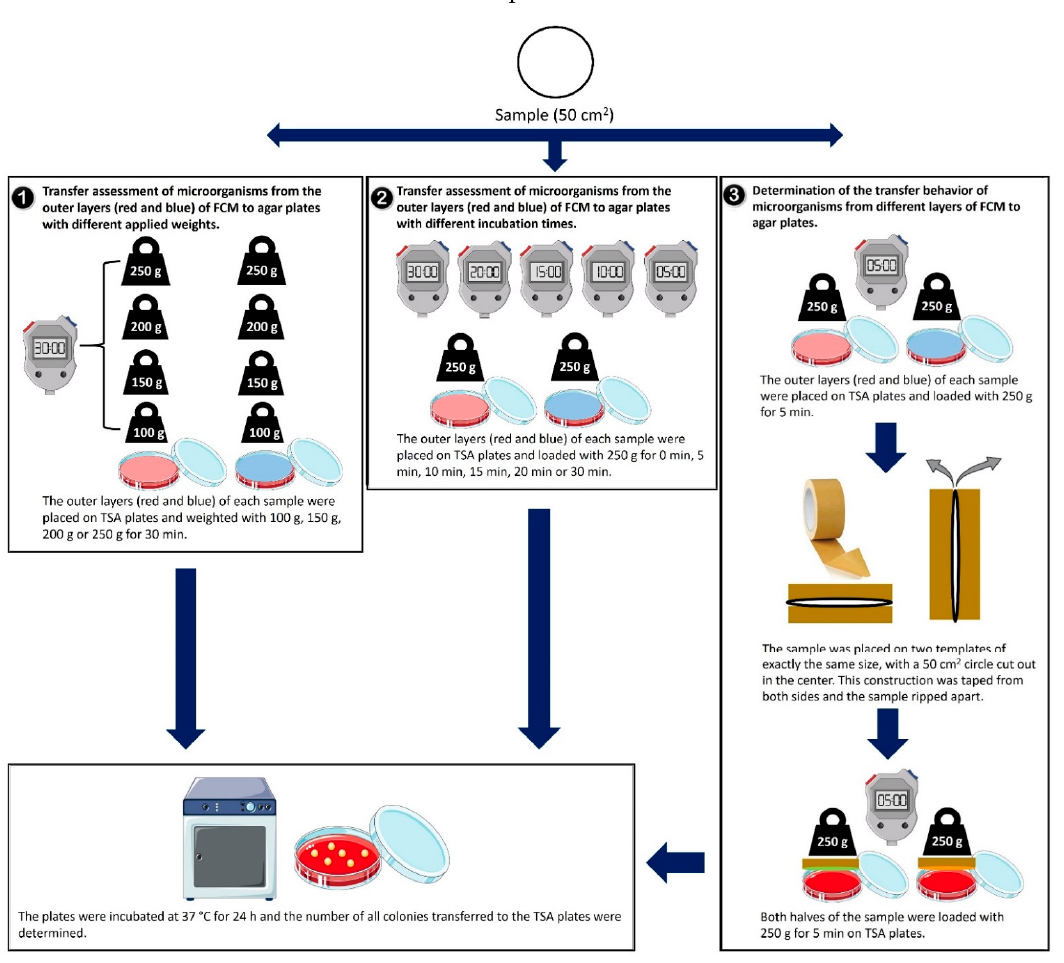
Figure 2. Experimental set-up to determine the transfer of microorganisms of food packaging ma- terials (FCM) tested with different applied weights ( 1 ), increasing incubation time ( 2 ) and outer and inner layers ( 3 ). From each packaging material, a circle with an area of 50 cm 2 was cut out. The outer layers (red: front, blue: back) of each sample were placed on tryptic soy agar (TSA) plates. ( 1 ) The transfer of microorganisms was measured by weighting the samples with 100 g, 150 g, 200 g and 250 g for 30 min. ( 2 ) The transfer of bacteria was measured by loading the samples with 250 g for 0 min, 5 min, 10 min, 15 min, 20 min and 30 min. ( 3 ) The transfer of microorganisms was not only observed from the outer (red and blue) but also from the inner layers (green and orange) of the sample. Therefore, the packaging material was split into two halves. The different layers were weighted with 250 g for 5 min on TSA plates. After the experimental setting of 1, 2 and 3, the agar plates were incubated at 37 °C for 24 h. Subsequently, the numbers of all colonies transferred to the TSA plates were determined. The weights and time experiments were performed eight times. Split- ting tests were conducted five times.